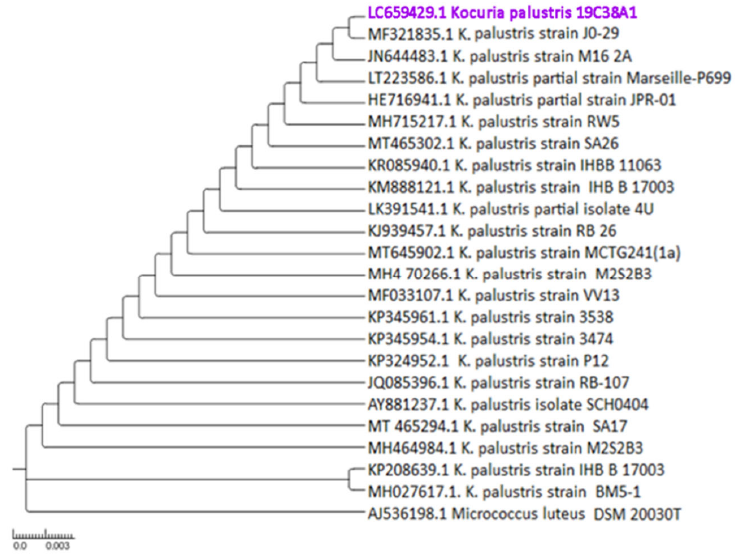
Figure 2. Phylogenetic tree using maximum likelihood method and Hasegawa–Kishino–Yano model of 23 Kocuria representatives and Micrococcus luteus (Acc. No. AJ536198) as an outgroup. Bootstrap values (1000 resamples) are given in percentages at the nodes of the tree. The isolate Kocuria palustris 19C38A1 was presented.